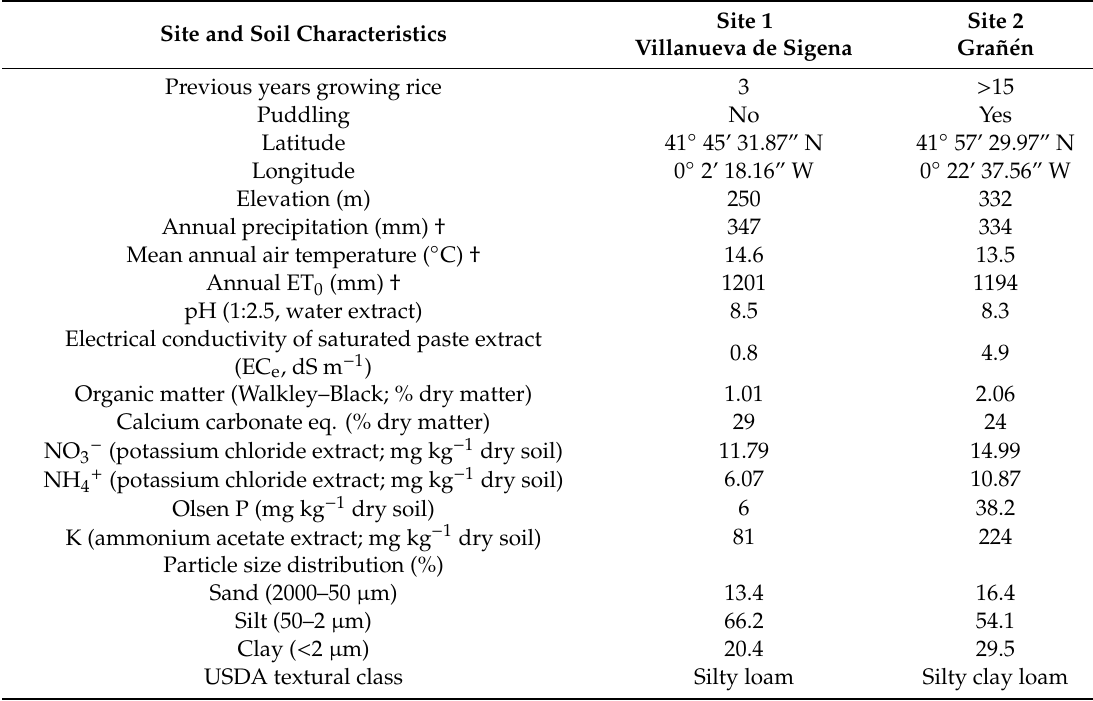
Table 1. Main site and soil characteristics in the 0–0.3 m soil depth at the beginning of the experiments at the two experimental sites. ET 0 is the Penman- Monteith reference evapotranspiration. Site 1 Site Site and Soil Characteristics